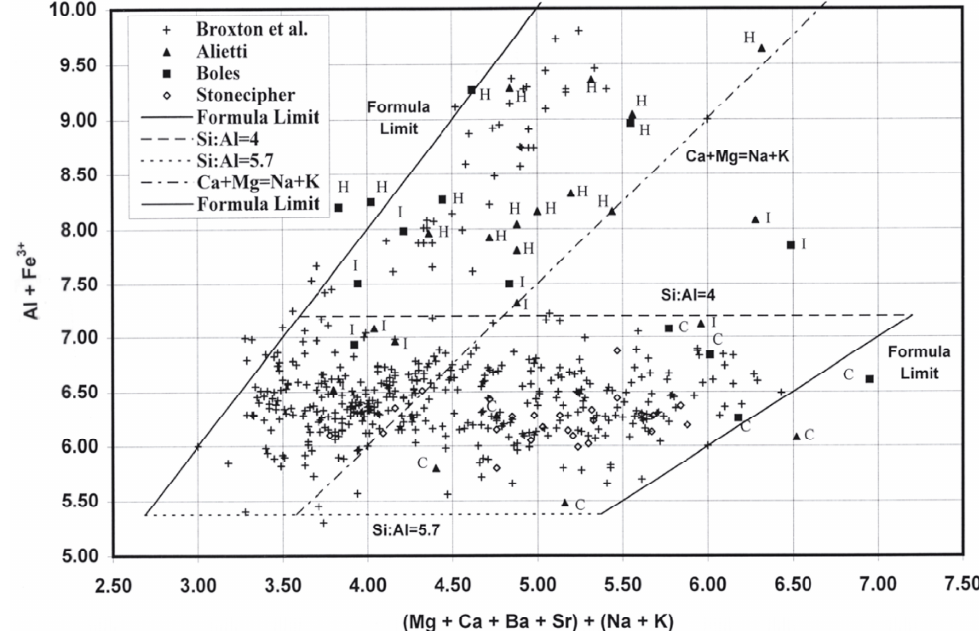
Figure 7. A plot showing the dependence between the composition of the crystal framework (Al 3+ + Fe 3+ ) (isomorphous substitution of the structural tetrahedron by ions; not only Al 3+ , but also Fe 3+ is allowed), and the sum of extra-framework cations for HEU zeolites family. The graph was constructed on the basis of literature data on the analysis of clinoptilolite and heulandite composition. Adapted with permission from Bish, D.L.; Boak, J.M., Rev Mineral Geochemistry ; Mineralogical Society of America, 2001 [66].